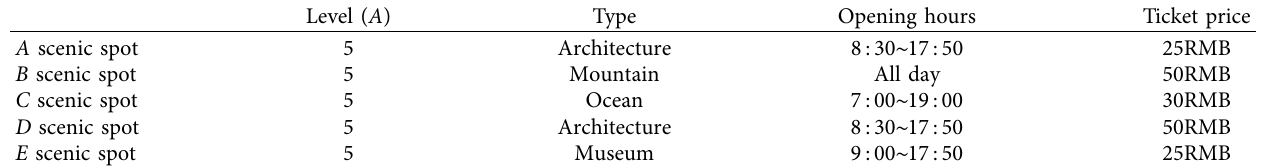
Table 1: Attraction information